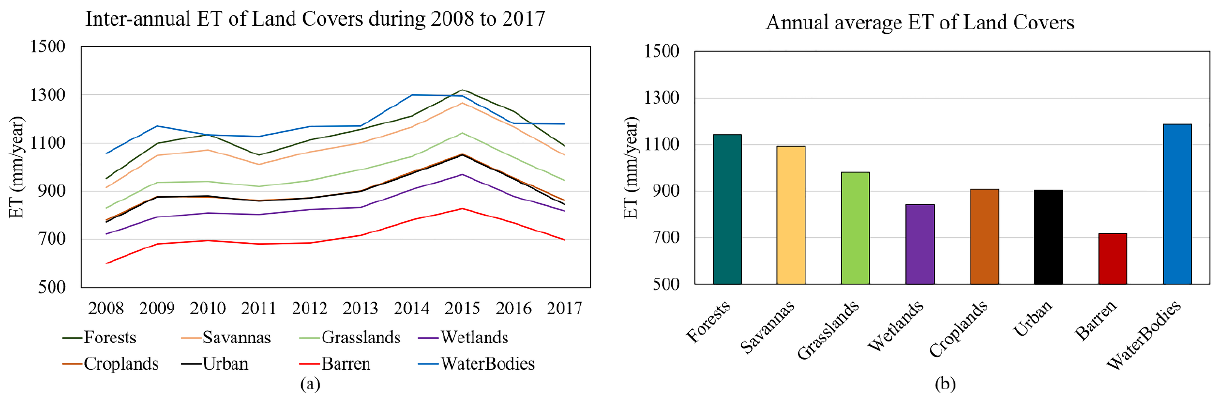
Figure 9. ( a ) The variation trend of annual ET in different land covers from 2008 to 2017. ( b ) The average annual ET of different land covers from 2008 to 2017.